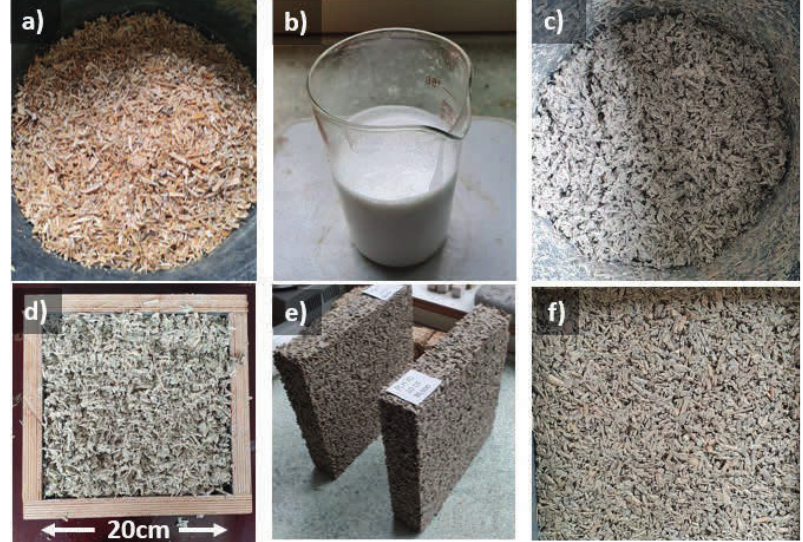
Fig. 3. The preparation procedure of gypsum hempcrete. a) hemp shives, b) PCM solution; c) fresh mixture of gypsum hempcrete, d) casted gypsum hempcrete samples; e) samples after demolding; f) macrostructure of gypsum hempcrete.